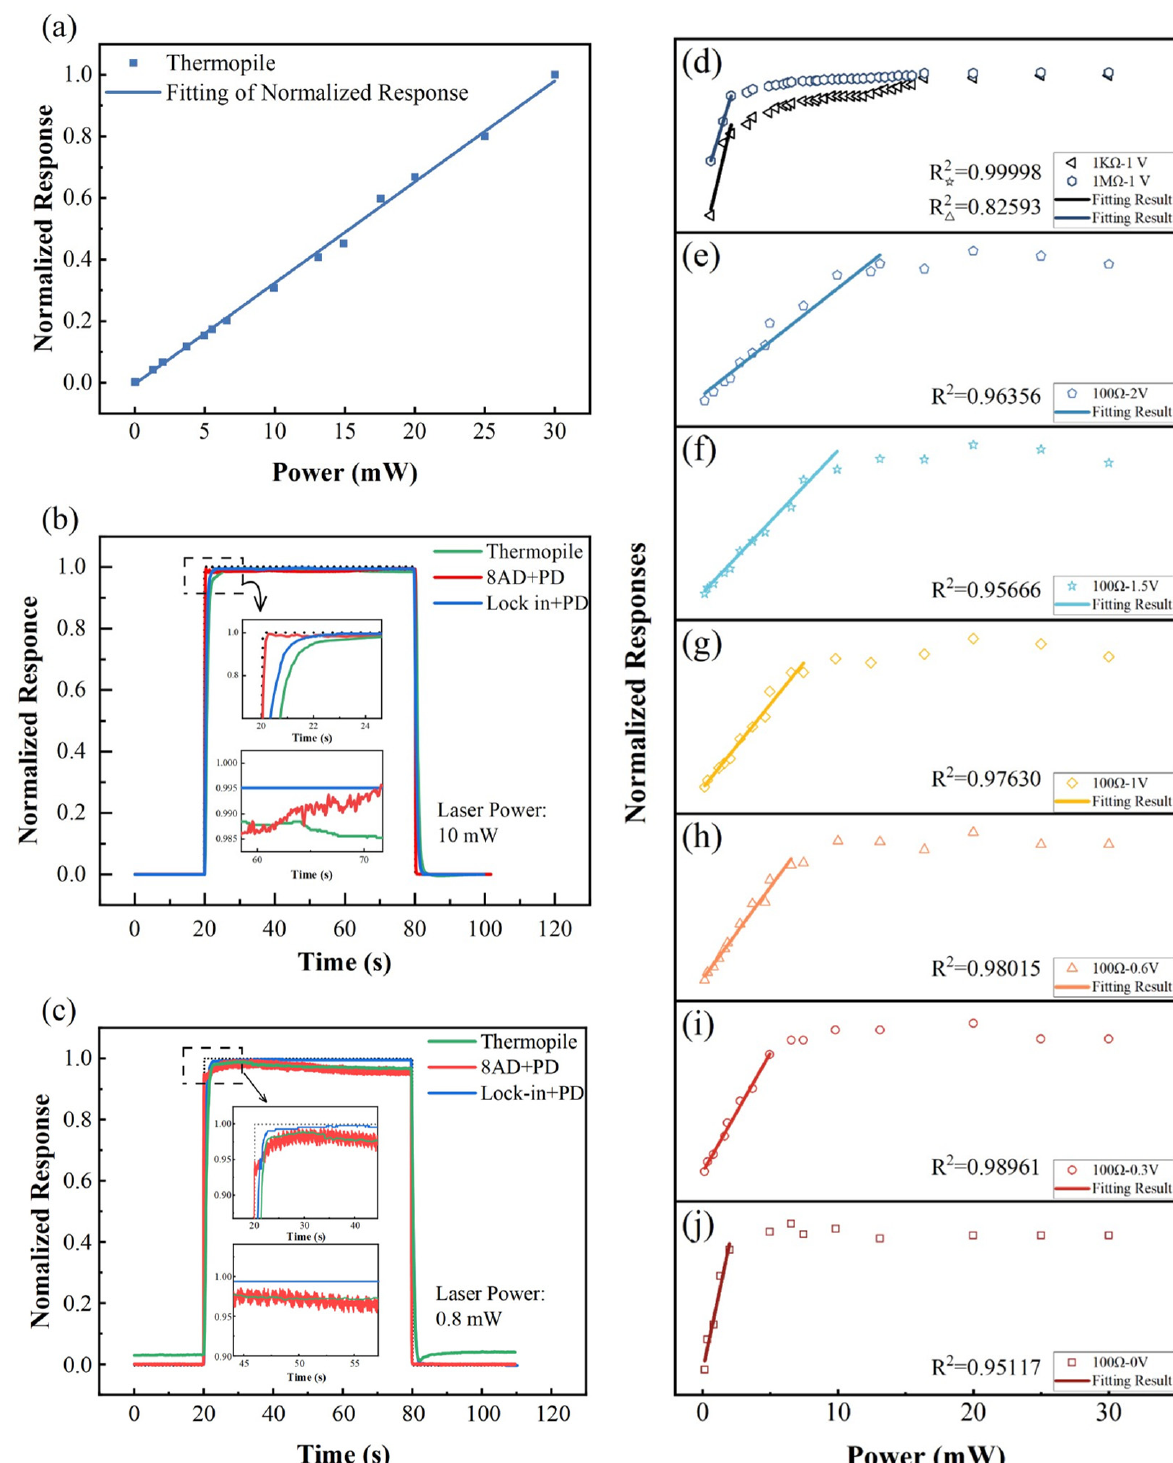
Figure 9. Comparison of levels of performance of three different optical power test units. ( a ) Linearity test of thermopile detector and power meter combination, ( b , c ) ON/OFF response test of three test units at 10 W and 0.8; ( d – j ) optical responses of photodiode detector for different bias voltages and load resistors.